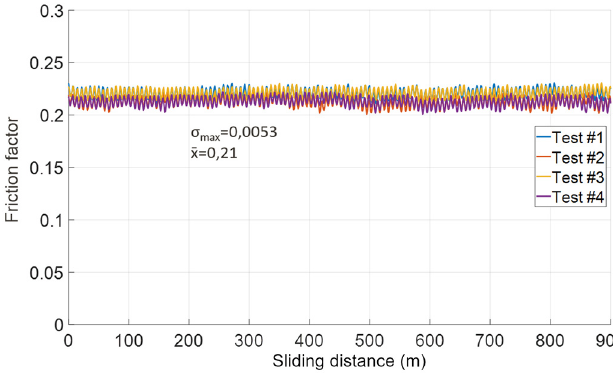
Fig. 9. Repeatability of a series of tests performed under a slip rate of 0.5 % with an R260 disc and ring, average: 0.21, maximum standard deviation: